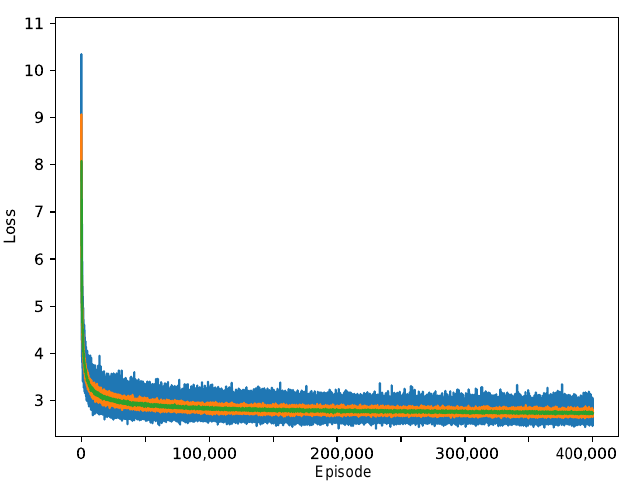
Figure 10. The loss function value in training the AtomicNet using infinite precision ADC. The blue line is the value of the loss function at each episode, the yellow line is the smoothed value with 20 episodes, and the green one is the smoothed value with 100